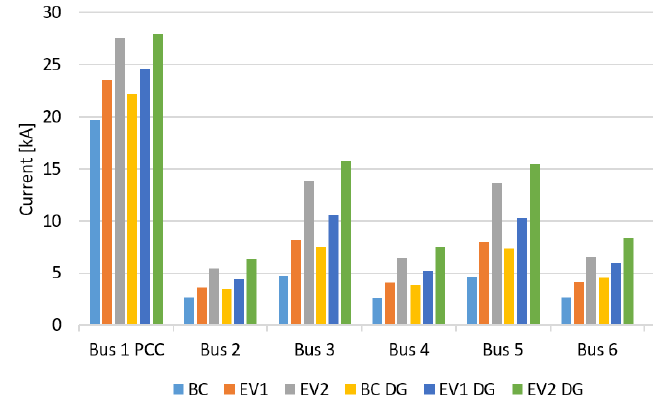
Figure 6. Short-circuit levels in all scenarios.